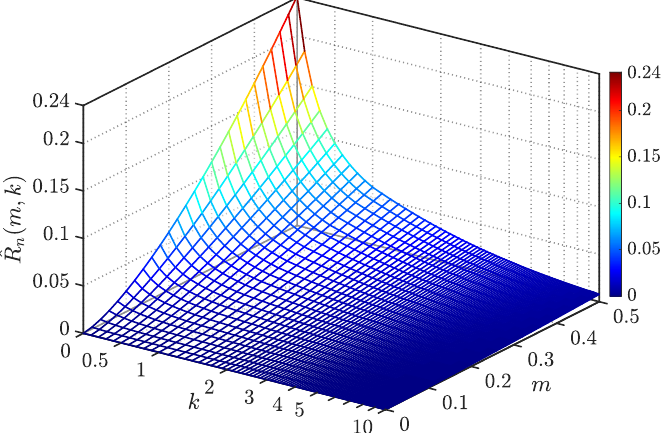
Figure 14. The normalized RMS value of a neutral switching current ripple as a function of modulat- ing index m and k factor.